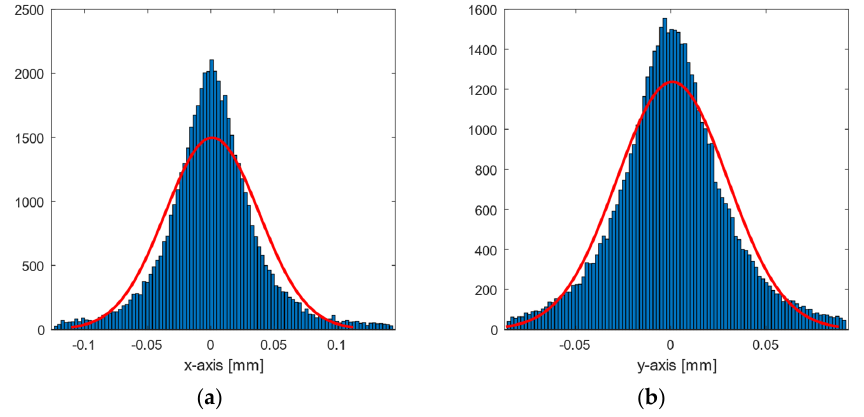
Figure 6. Histogram plot of the 97th percentile for inner area data error concerning their means on the ( a ) x -axis and ( b ) y -axis. The red line represents a normal distribution as a comparison.